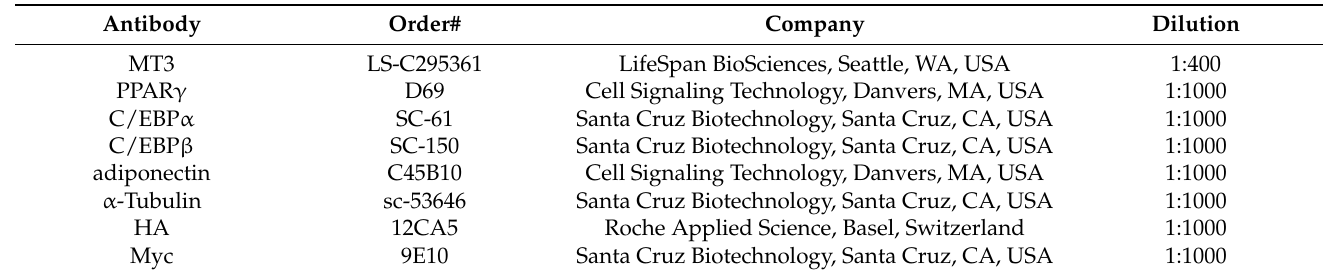
Table 1. The primary antibodies used for immunoblotting.